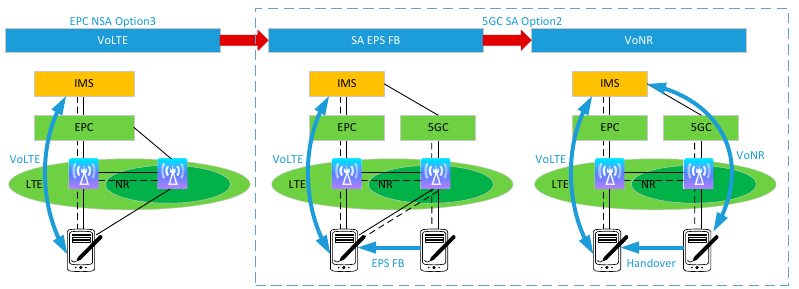
Figure 2. 5G voice service evolution.